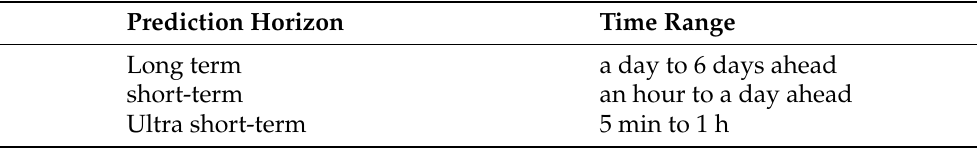
Table 1. Prediction horizons in